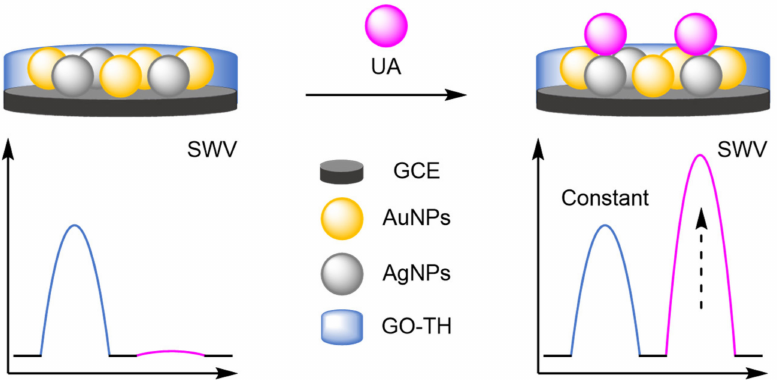
Figure 28. Schematic representation of a metal nanoparticles-based modified electrode for the detection of uric